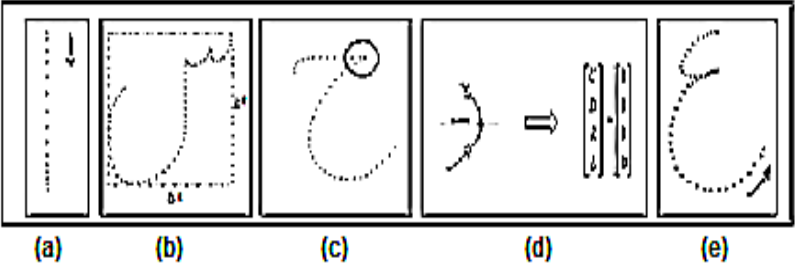
Figure 4. Statistical features: ( a ) common trend while writing Urdu character “Alif”; ( b ) slope value of the character-box for Urdu character “Seen”; ( c ) identification of a cusp in Urdu character “Hey”; ( d ) feature vector having intersection points of Urdu character “Daal” (U: up, D: down, R: right, L: left); ( e ) finishing trend of Urdu character “A’en”